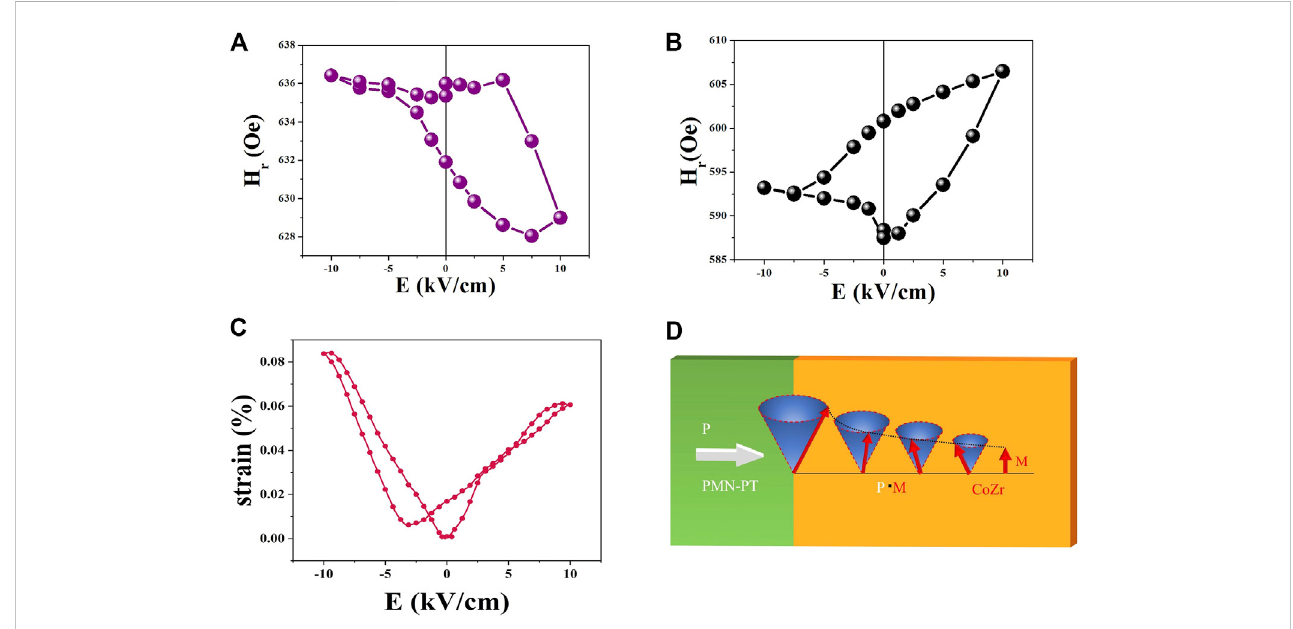
FIGURE 4 H r − E curve at the hard axis under various electric fi elds for the CoZr layer along (A) (01 – 1) and (B) (100) of the PMN – PT substrate; (C) S – E curve; (D) schematic of P – M interaction